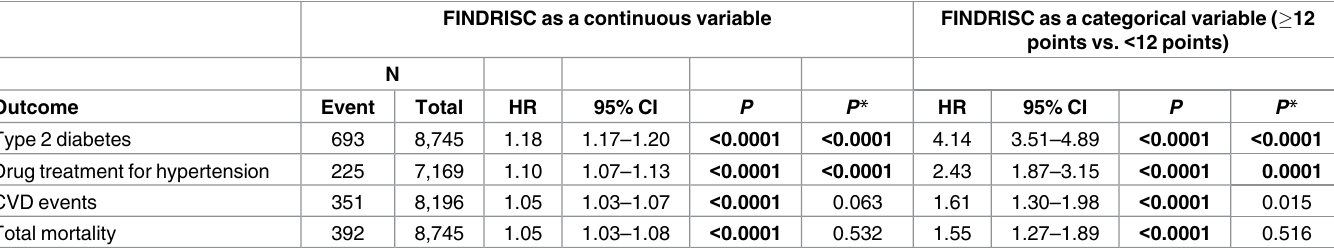
Table 3. The association of the Finnish Diabetes Risk Score (FINDRISC) with incident type 2 diabetes, new drug-treated hypertension, cardiovas- cular (CVD) events and total mortality in the METSIM follow-up study. FINDRISC as a continuous